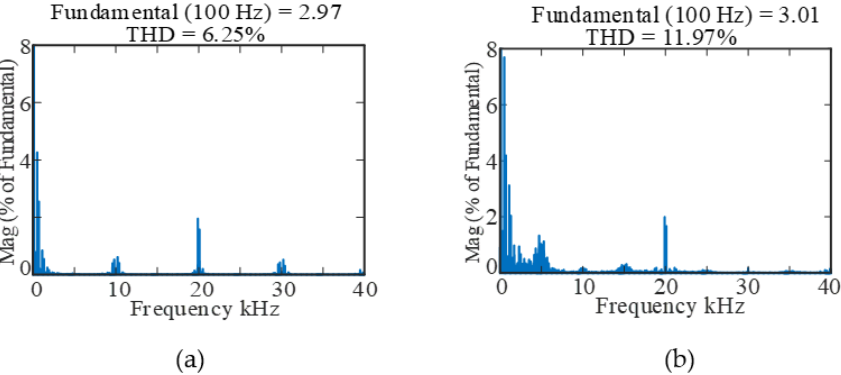
Figure 6. Steady-state stator current harmonic spectrum. ( a ) Proposed MPDSC. ( b ) Double-vector MPDSC.